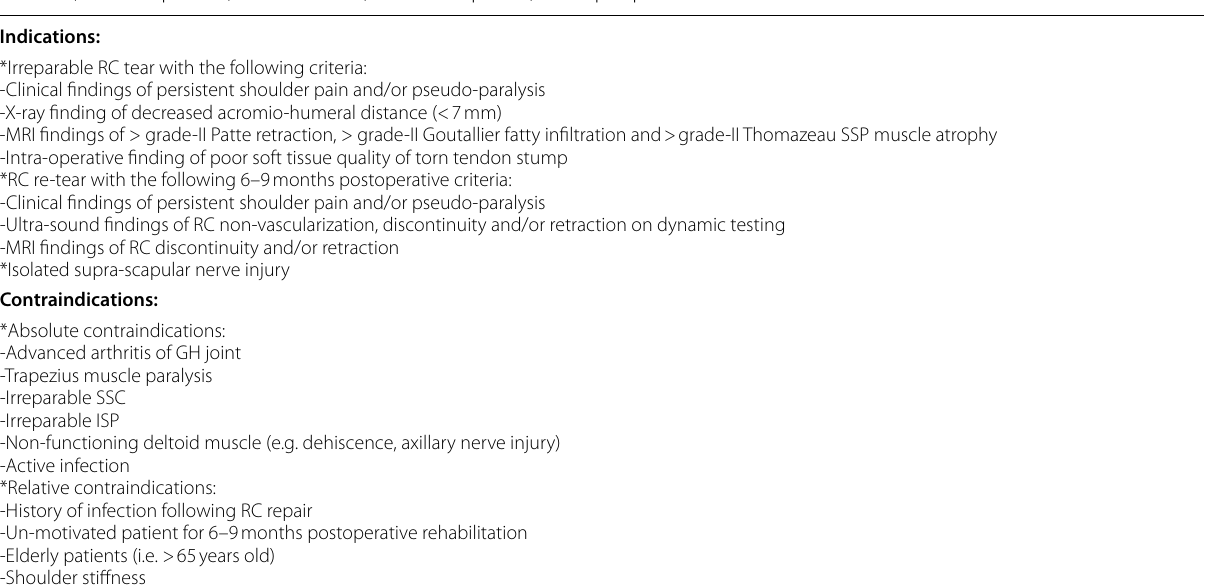
Table 2 Summarizes indications and contraindications of currently reported technique of middle trapezius tendon transfer; GH gleno‑ humeral, ISP infraspinatus, RC rotator cuff, SSC subscapularis, SSP